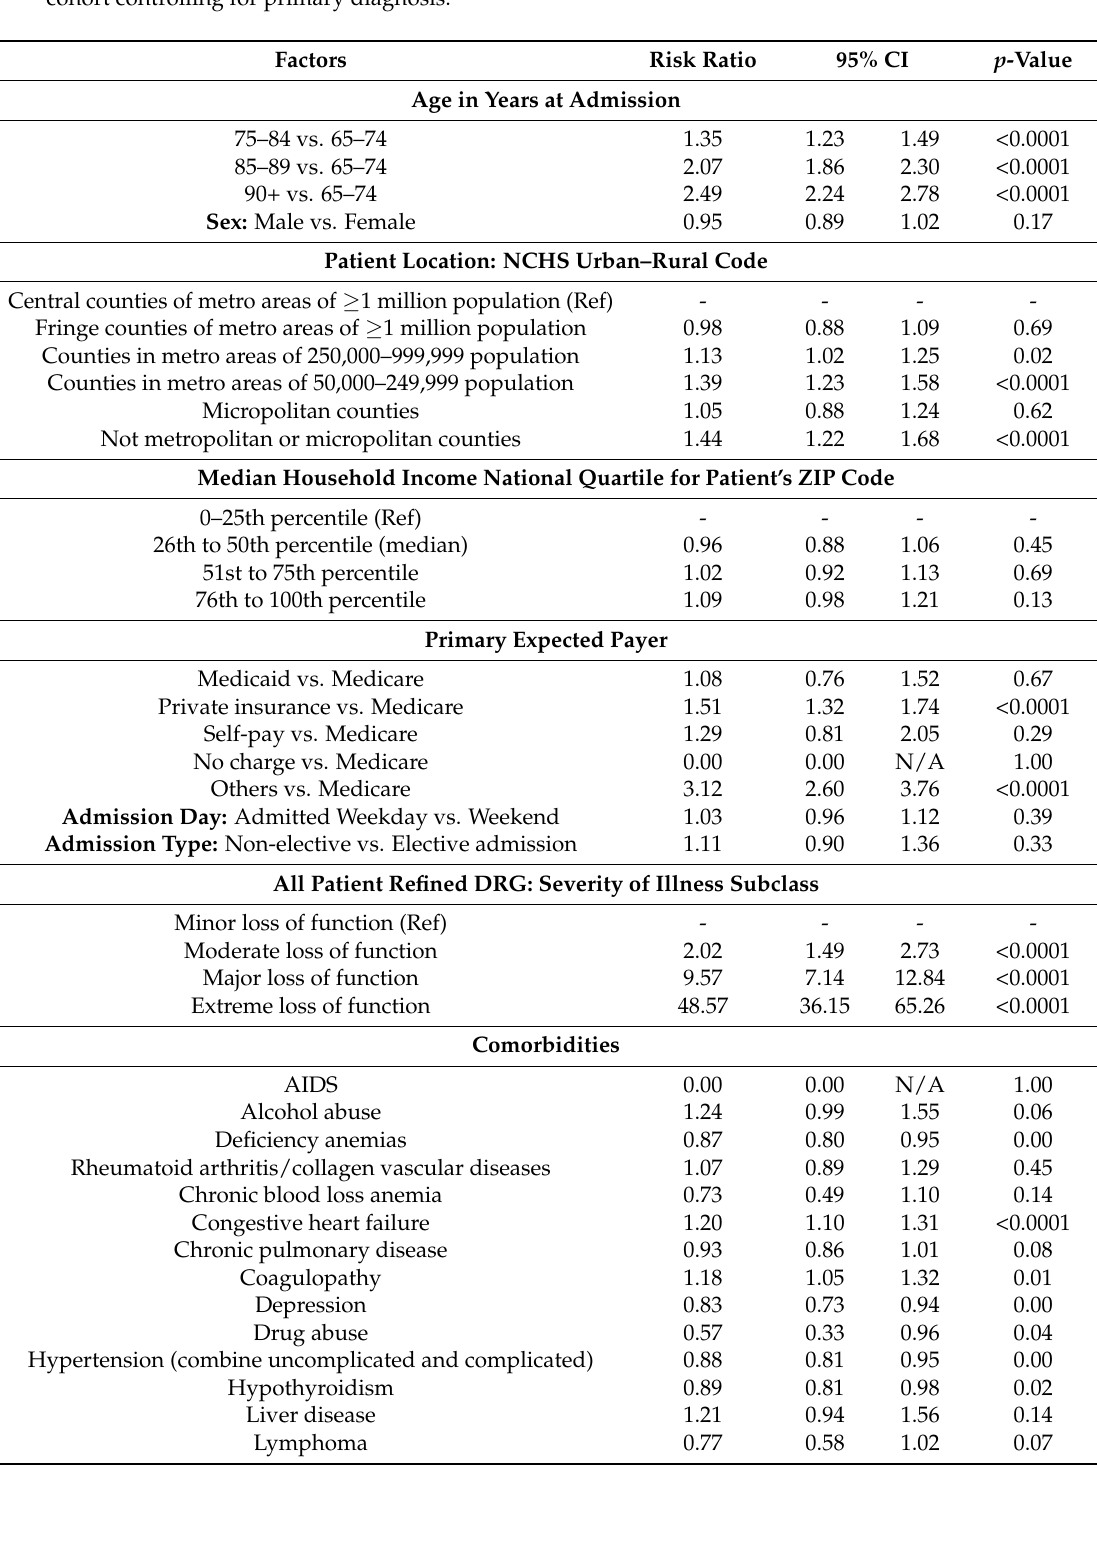
Table 3. Multivariable regression results showing risk factors for inpatient mortality among the total cohort controlling for primary